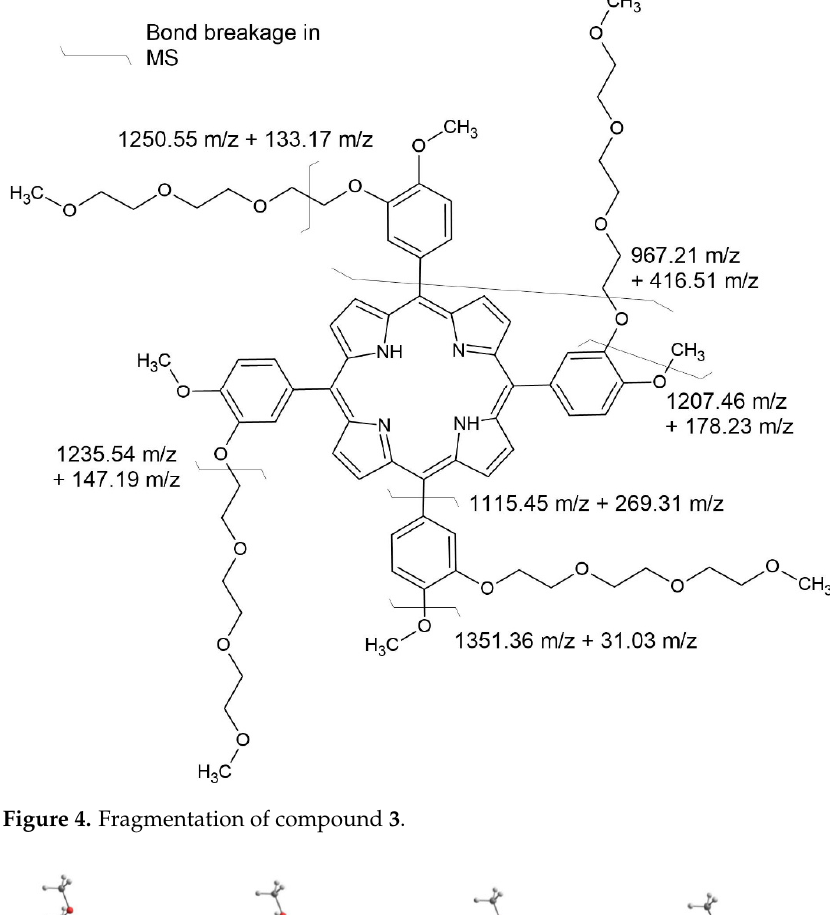
Figure 4. Fragmentation of compound 3 .